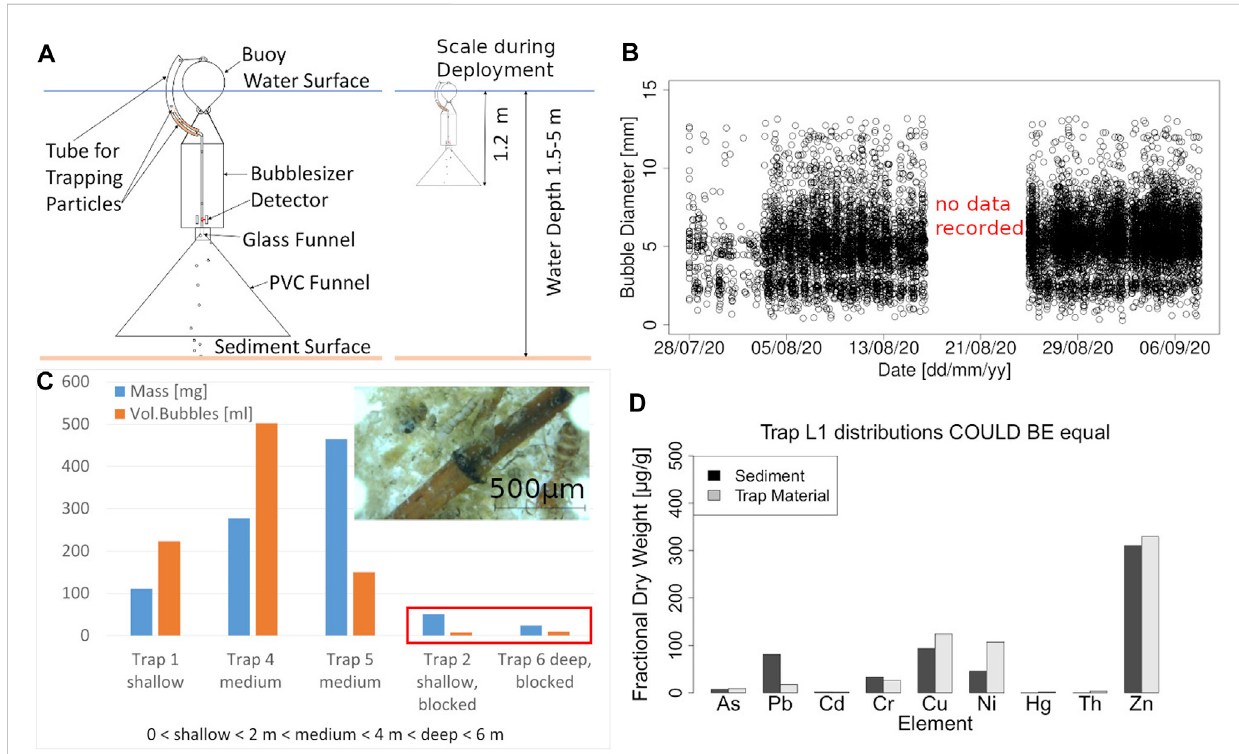
FIGURE 1 (A) Deployment schematics of an optical bubble sensor. (B) Time series of bubble size distributions (each symbol represents a single bubble) measured in a freshwater reservoir. Note that the periodicity in time (approx. 6 h) results from intermittent measurement intervals. The bi-modal size distributionismostlikelycausedbythefunnelgeometry,whichleadstomergingofbubblesintolargeroneswithintheglassfunnel. (C) Barchartshowing themassofcollectedmaterialinMay2021inblueaswellasthevolumeofbubblesinorangeduringthesametime.Intheredrectanglearetwotraps that served as a reference for the accumulation of material without bubbles as well as the background of the bubble detection. All values below 50 are mostlikelynot causedbyebullition. Thesmallerpictureshowsmaterialfoundininthebubbletrap. Wemonitoredebullitionoverthecourseof1 year ina pre-dam attheWupper River in Germany with optical bubble trapsbased on Delwiche and Hemond (2017),(Delwiche and Hemond, 2017).After half ofa yearcollectiontubesforparticulatematterwereadded.The collectedmaterialwasdried, weighedand analyzedbyICP-MStocomparethecomposition ofmetalionsinthesampleswithprevioussedimentanalysis. (D) Comparisonofmetalconcentrationsindriedmaterialfoundinthebubbletrapandinthe sediment of the